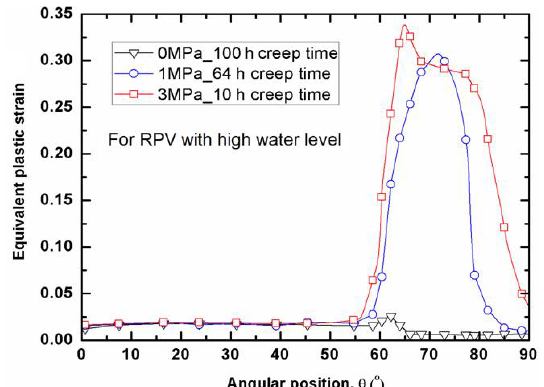
Figure 8. Effect of internal pressure on plastic strain distribution for RPV with high water level.